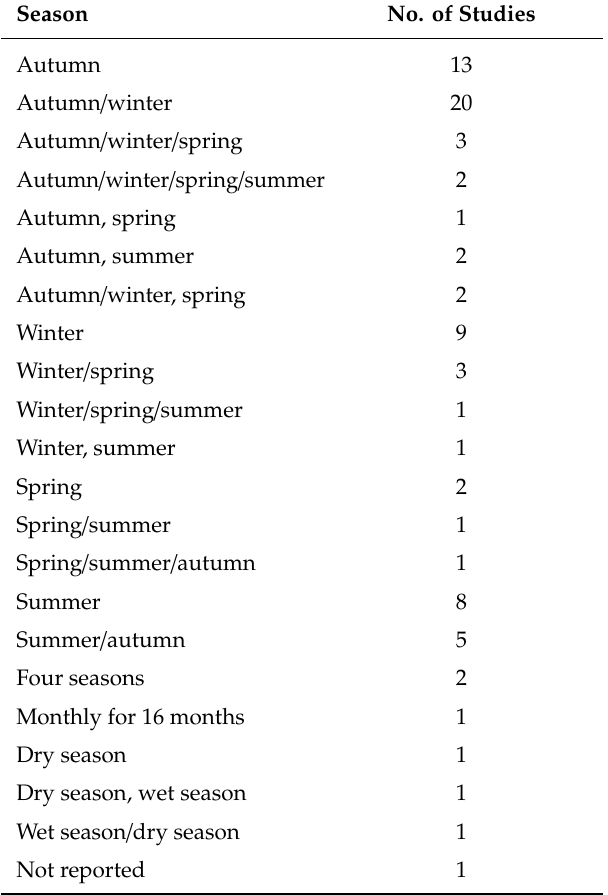
Table 2. Season during which organic matter was incubated in field studies ( n = 81). The slash (“ / ”) indicates that the litter was incubated over multiple seasons; the comma (“,”) indicates multiple incubation